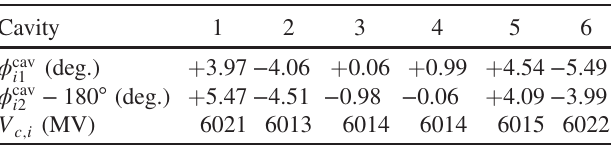
TABLE I. Effective cavity ( ϕ cav ij ) phases and cavity voltages for theoretical perfectly energy balanced configuration.